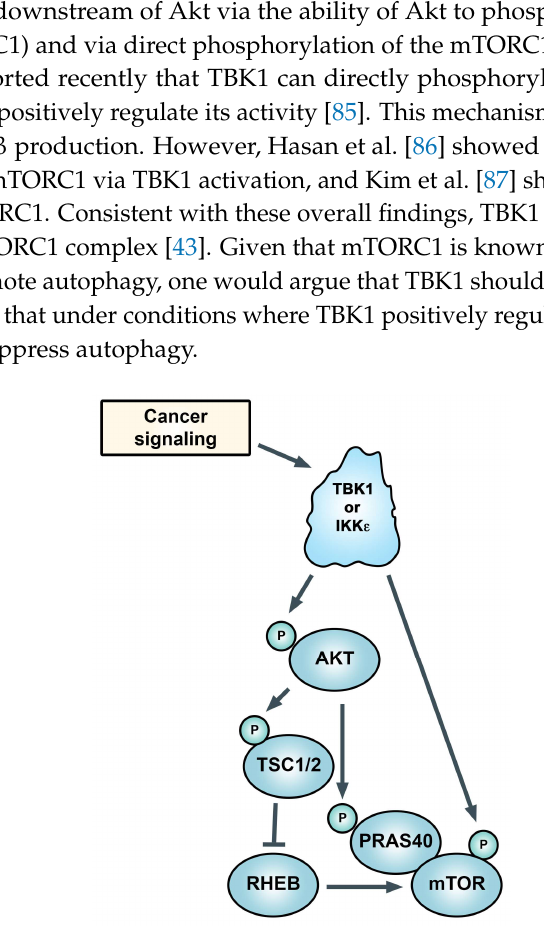
Figure 3. TANK-binding kinase 1 (TBK1) and I κ B kinase epsilon (IKK ε ) control Akt phosphorylation and its activity (in some settings), which drives mechanistic target of rapamycin complex 1 (mTORC1) activity. TBK1 is also reported to directly phosphorylate mTOR. See text.